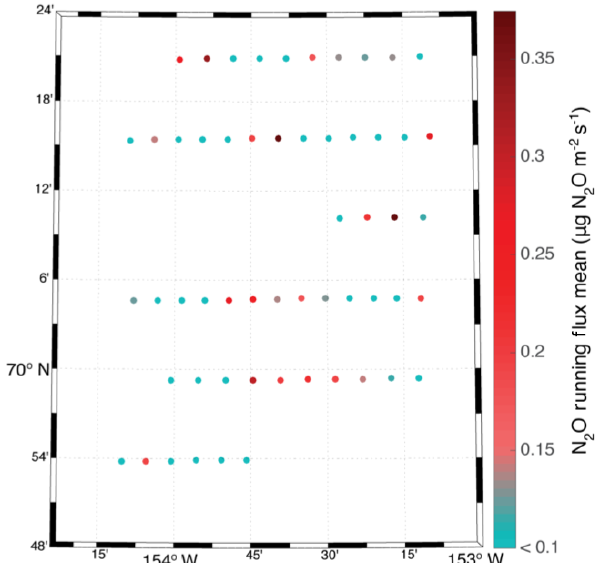
Figure 6. Spatial flux map for Flight 28.10, where the circles on the map each represent the N 2 O flux averaged over 6km with a 3km overlap. Values within ± 0 . 1µgN 2 Om − 2 s − 1 are treated as